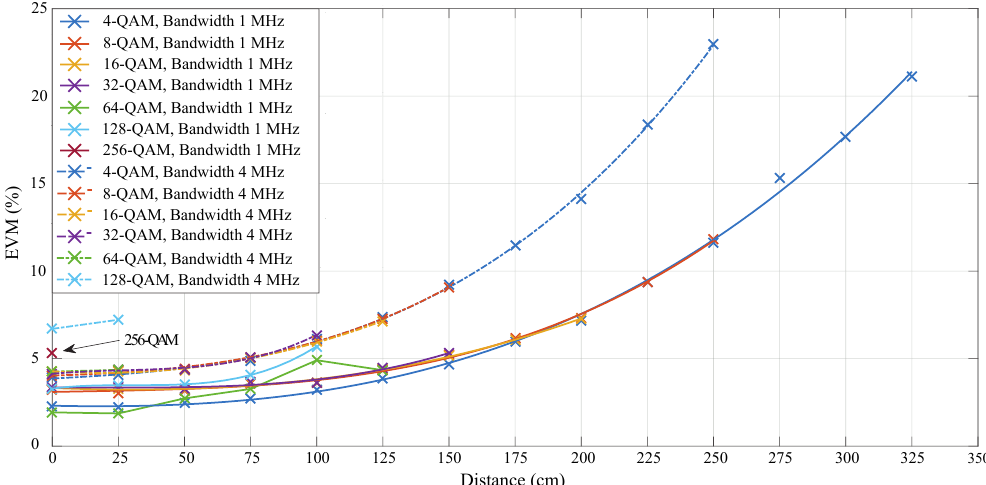
Figure 11. EVM/distance from center relationship for ceiling light with different M-QAM and